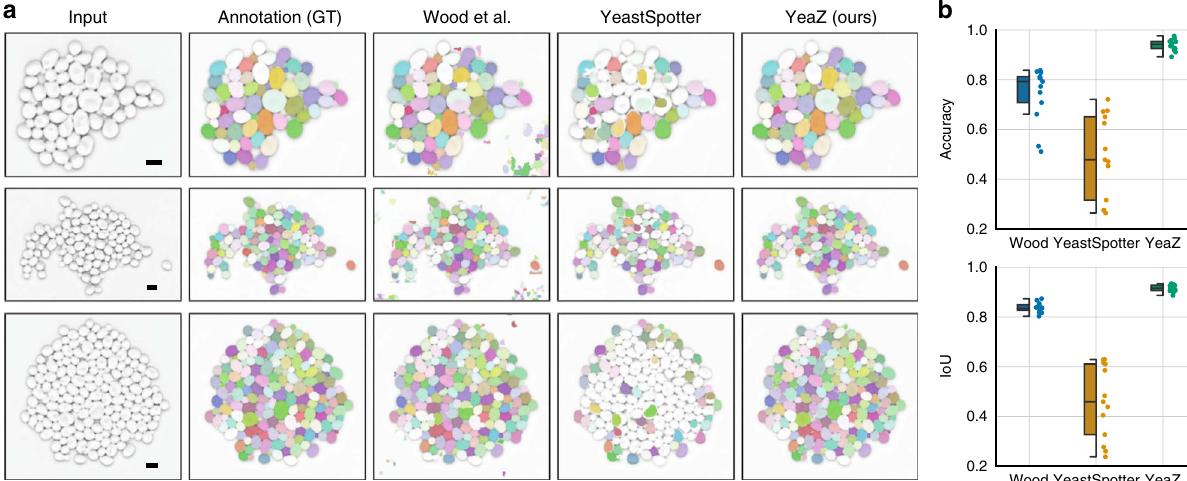
Fig. 5 Detailed computational comparison of all methods. The evaluations were carried out on 17 test images of 1894 cycling wild-type cells not included in the YeaZ training set. a Each row shows an example test image, its ground-truth annotation (GT), and the result of Wood et al. 9 , YeastSpotter 14 , and YeaZ, respectively. b Quanti fi cation of segmentation performance of all methods. As is common in the computer vision literature, we call a predicted cell a true positive (TP), if its intersection over union (IoU) with the corresponding ground-truth (GT) cell is larger than or equal to 50%. Similarly, false positives (FPs) and false negatives (FNs) are de fi ned as predictions that have no GT match and vice versa. As segmentation metric, we show the average accuracy (